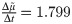
Predicted mutational burden in individual stem cells with age.a) We show simulated stochastic mutation accumulation in a stem cell population of constant size. Here N = 20,000 stem cells segregating DNA strands with probability p = 0.7 and a mutation rate of μ = 6 per cell division (corresponding to a mutation rate of μ = 10−9 per bp per cell division). b) Mutational burden and c) variance of the mutational burden increase linear. Linear regression (dashed lines) gives Δμ˜Δt=1.799 and Δσ2Δt=9.41. The expected exact values based on above parameters and Eqs (1) and (2) are Δμ˜Δt=1.8 and Δσ2Δt=9.36. Eqs (3) and (4) yield for the strand segregation probability p = 0.702 and for the mutation rate μ = 6.03, (exact values imposed on the simulation were p = 0.7 and μ = 6).